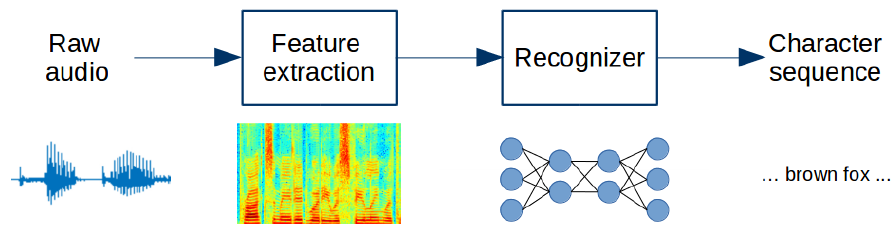
Figure 1. General architecture for an end-to-end speech recognition